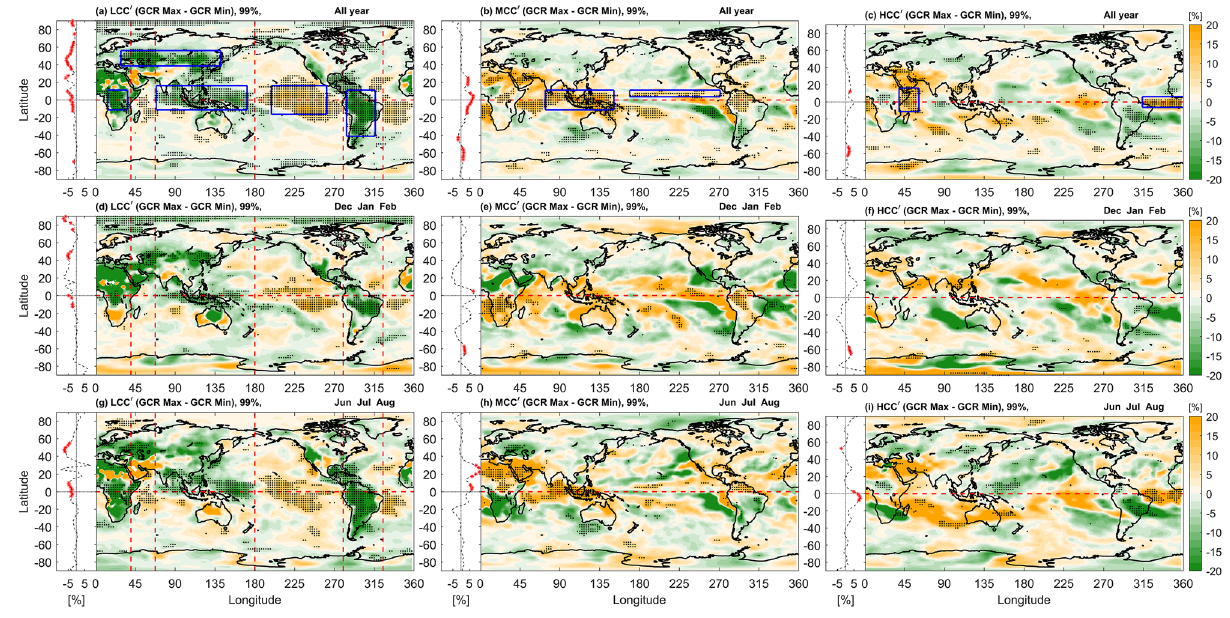
Figure 2. Plan views of composite differences between the GCR max—GCR min groups. From left to right, ′ ′ ′ columns represent the LCC , MCC , and HCC anomalies respectively. The top row, ( a – c ) is for all year data, middle row, ( d – f ) for DJF data, and bottom row, ( g – i ) for JJA data. Black dots highlight the areas where statistical significance exceeds 99% in the composite difference. The associated plot on the left in dashed lines with each panel presents the zonal mean structure, and the red star markers indicate the latitudinal zone where composite differences exceed 99% statistical significance. The red color dashed lines over the LCC panels ( a , d , g ) represent the ascending/descending branch of the WC. The blue rectangular boxes are the selected domains for the time series analysis shown in Fig.